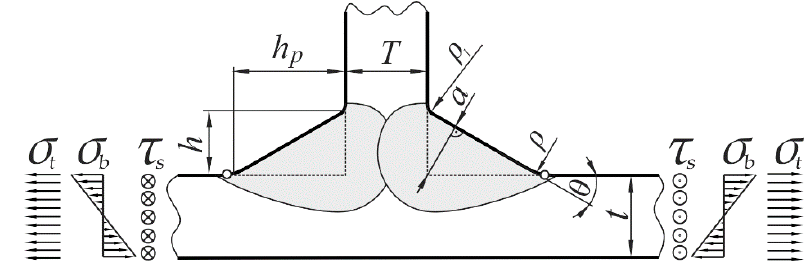
Figure 1. Geometrical parameters and loading modes of the plate